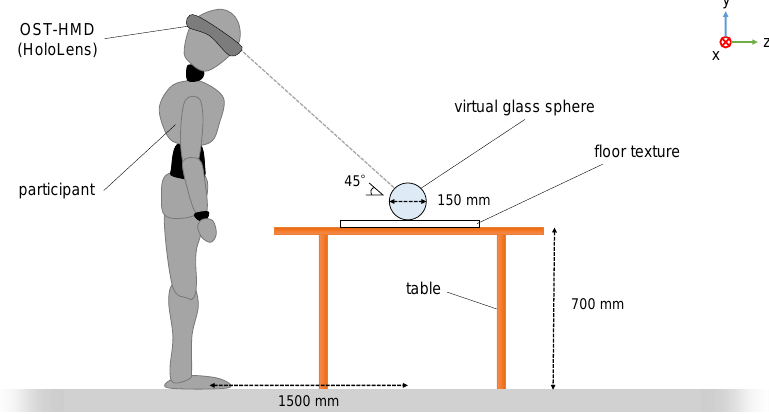
Figure 5. Experimental